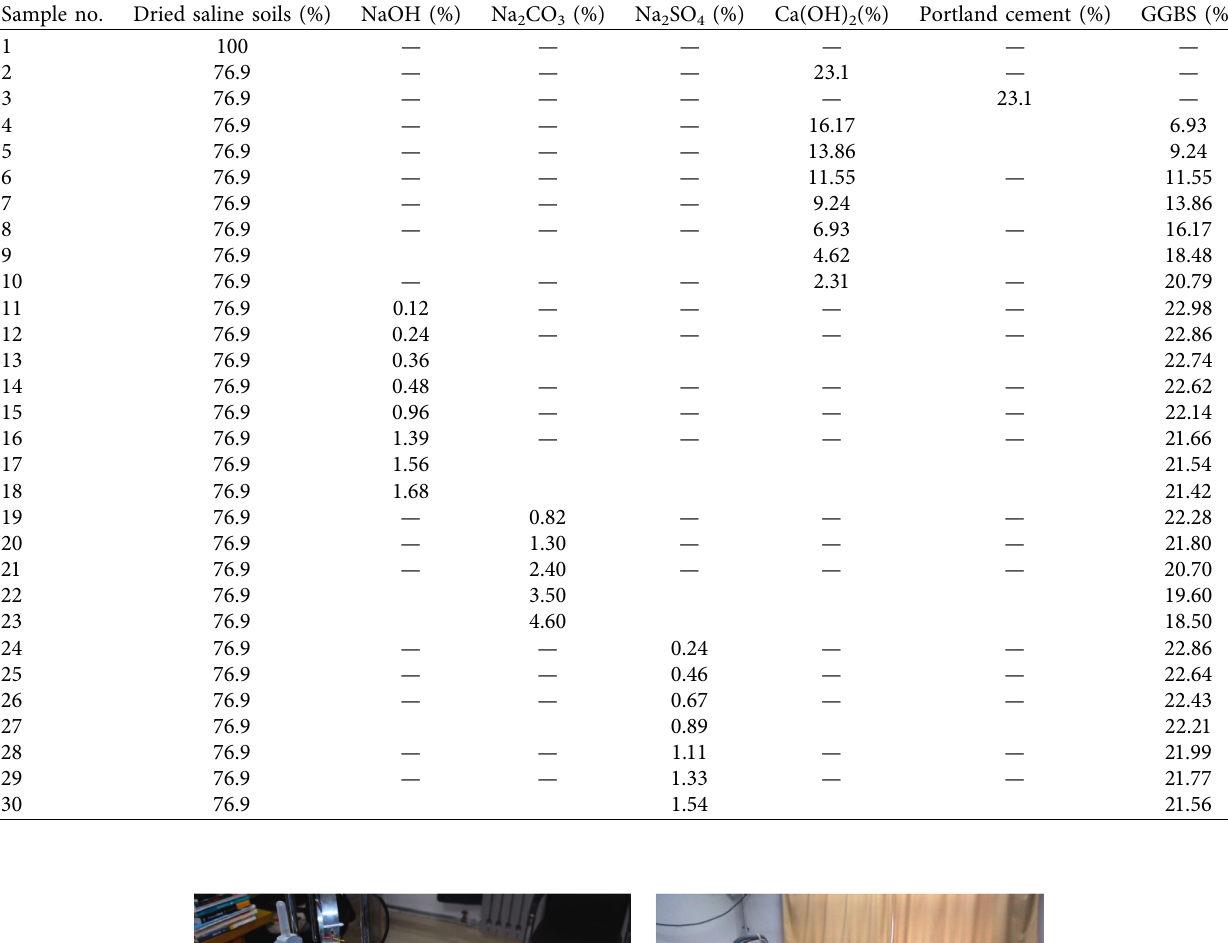
Table 6: Experiment scheme for saline soils sample.